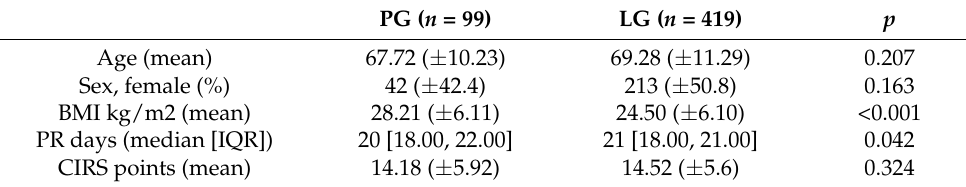
Table 2. Comparison of the post-COVID-19 group (PG) to the lung diseases group (LG).